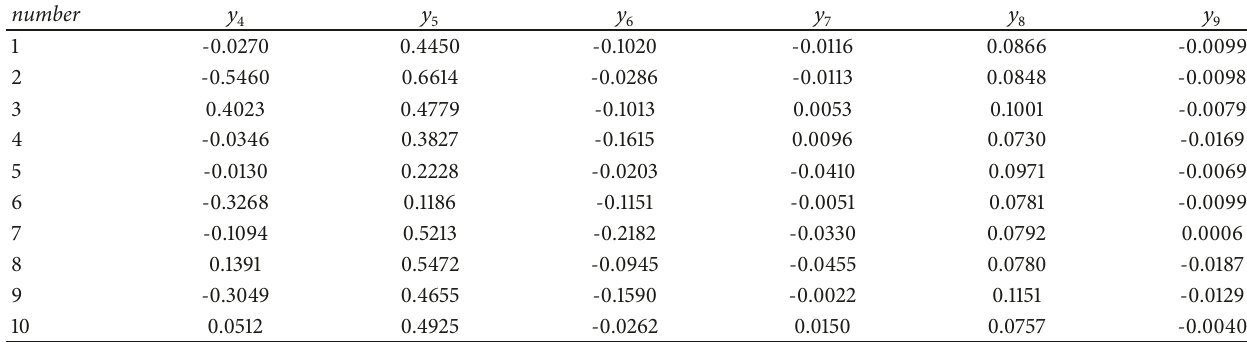
Table 8: The category feature of multiwavelet entropy of the severe drought stress